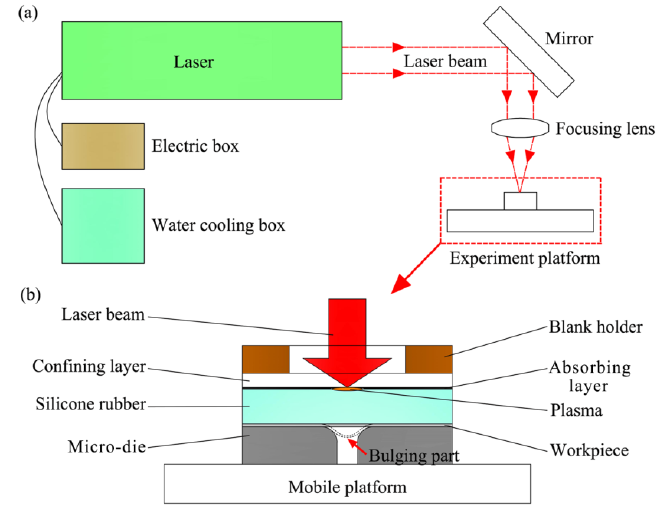
Figure 1. ( a ) The formation system of laser flexible shock micro-bulging; ( b ) experimental principal of laser flexible shock micro-bulging.